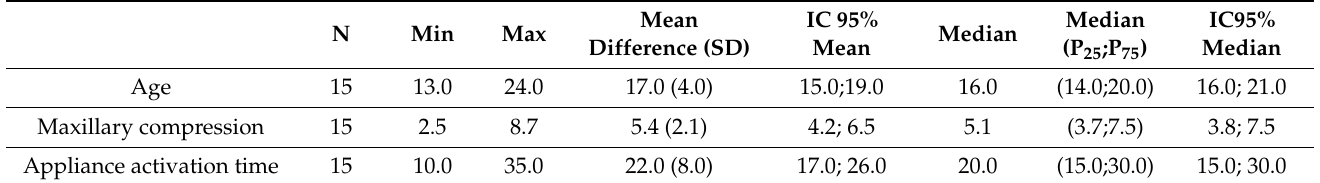
Table 1. Sample age and maxillary compression distribution. Appliance’s activation time. Age (years), Maxillar compression (mm), Appliance activation time (days).